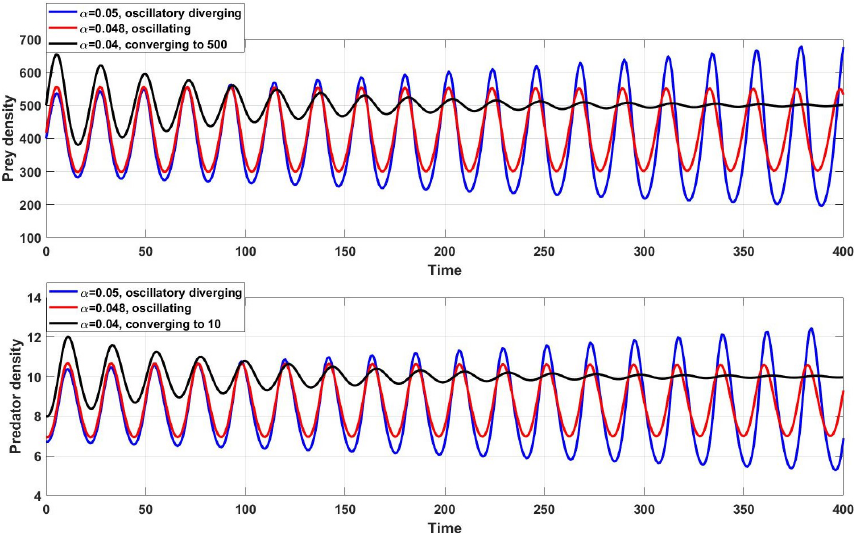
Figure 1. Demonstration of the different dynamics that can arise with the discrete Ricker-type system (1) when the parameter α is varied. This system is solved with K = 2500, γ = 0.01, c = 0.2 and r = 0.5. For three different α values 0.05,0.048 and 0.04, the predator-prey populations diverge, converge very slowly and converge, respectively. Here, system (1) is derived for a unit step size, which is similar to system (2) when h =